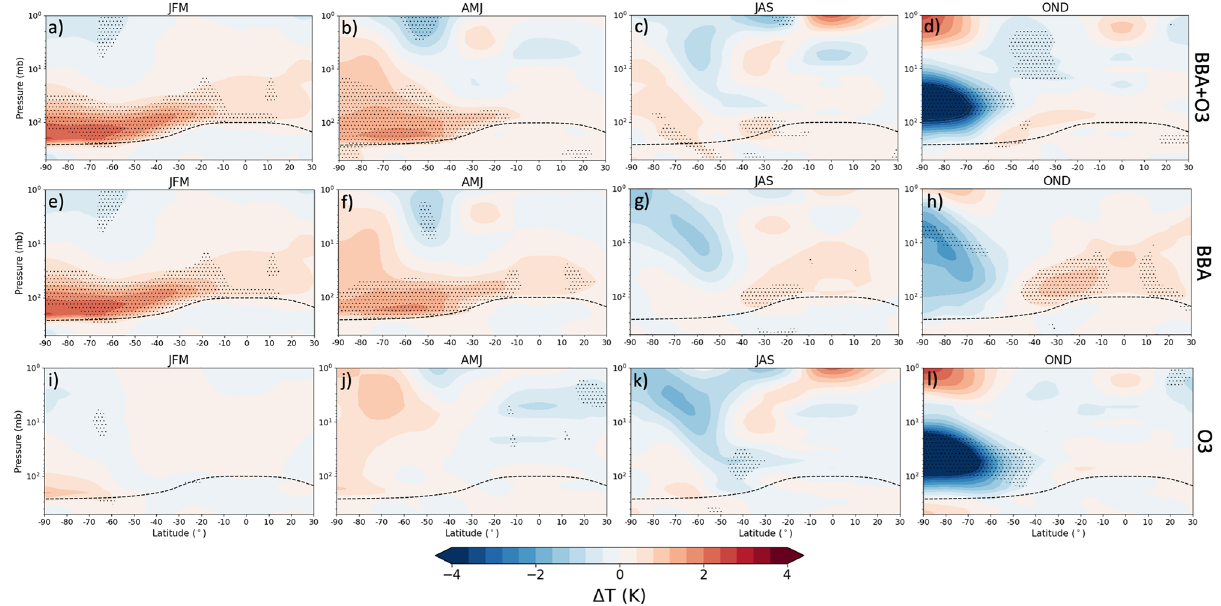
Figure 5. Three-monthly mean modelled perturbations to atmospheric temperature ( K ) due to the smoke aerosol forcing ( e–h ), the ozone anomaly ( i–l ), and both the smoke aerosol and ozone ( a–d ). The stippled points show the points at which the experiments were significantly different from the control simulations at a 5% significance level (calculated by a Welch’s t-test). The black dashed line shows the average tropopause height from the UKESM1 model